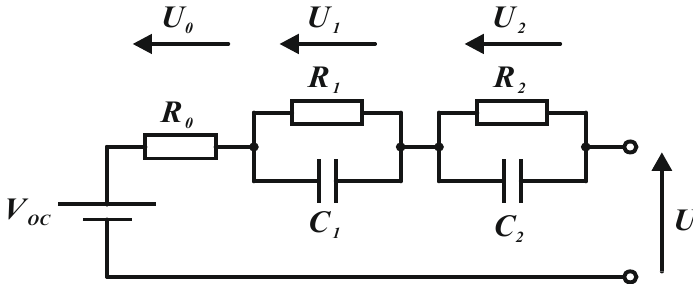
Figure 11. The equivalent diagram of the lithium-ion battery model.